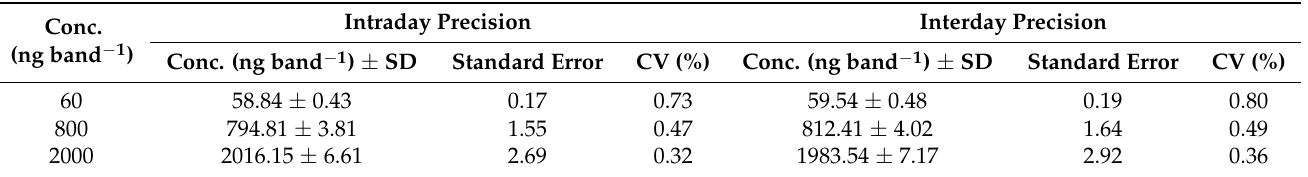
Table 4. Evaluation of intra/inter-day precision of HSP for a sustainable RP-HPTLC assay (mean ± SD; n = 6). Conc.